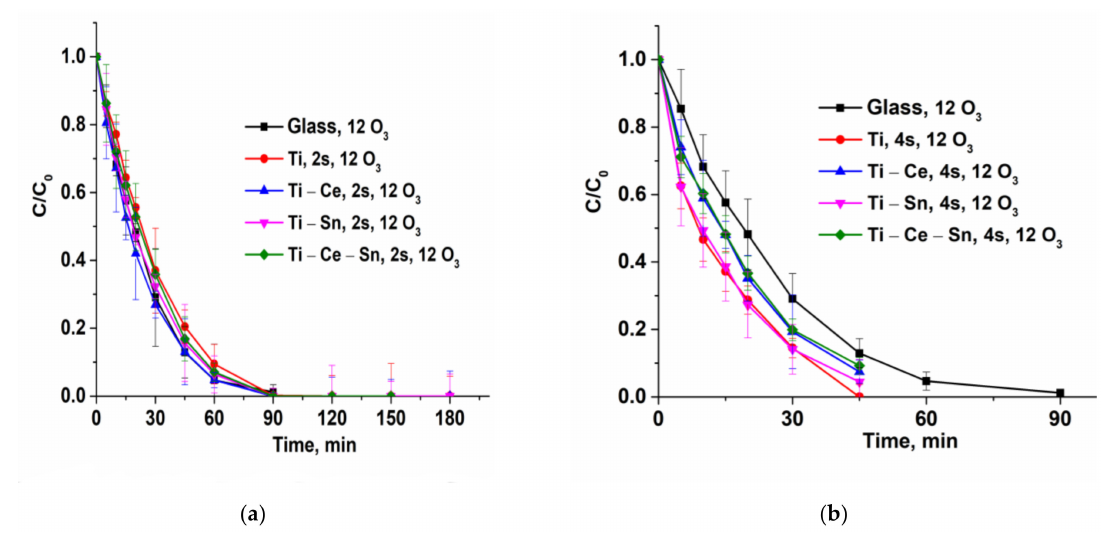
Figure 7. ( a ) Comparison of prepared catalytic systems at a higher ozone input and two slides; ( b ) Comparison of prepared catalytic systems at a higher ozone input and four